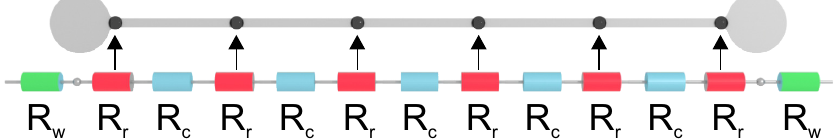
Figure 2. Electrical configuration of the developed strain sensor. R c is the electrical resistance of single segments of the intermittent structure, R r resistance of a single resistive element, n is a number of the resistive elements in the entire sensor structure, R w resistance of wires attached to the